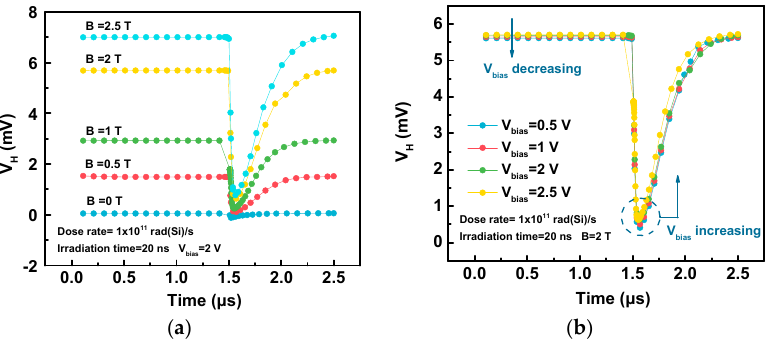
Figure 6. The changes in Hall voltage ( V H ) during the irradiation of ( a ) dose rate = 5 × 10 8 ~1 × 10 11 rad(Si)/s and ( b ) dose rate = 5 × 10 11 ~5 × 10 12 rad(Si)/s. The inset in ( a ) is the change in minimum Hall voltage ( V H min ) with dose rate.